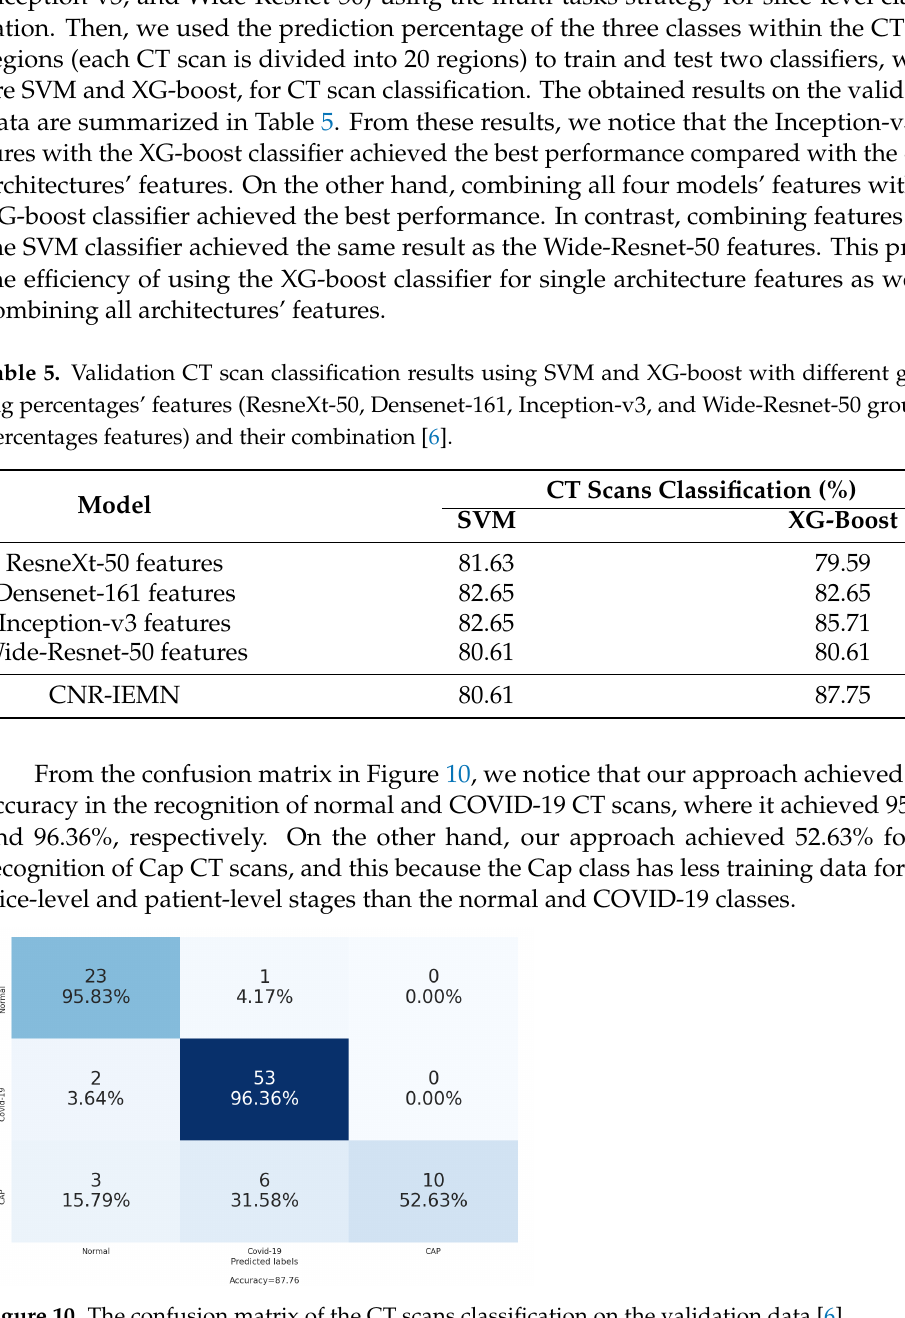
Figure 10. The confusion matrix of the CT scans classification on the validation data